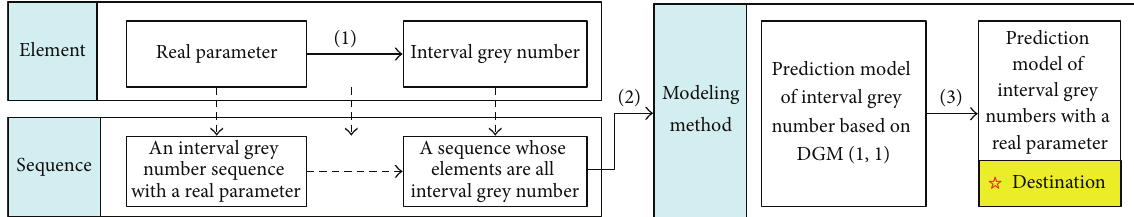
Figure 2: Process of modeling of interval grey numbers with a real